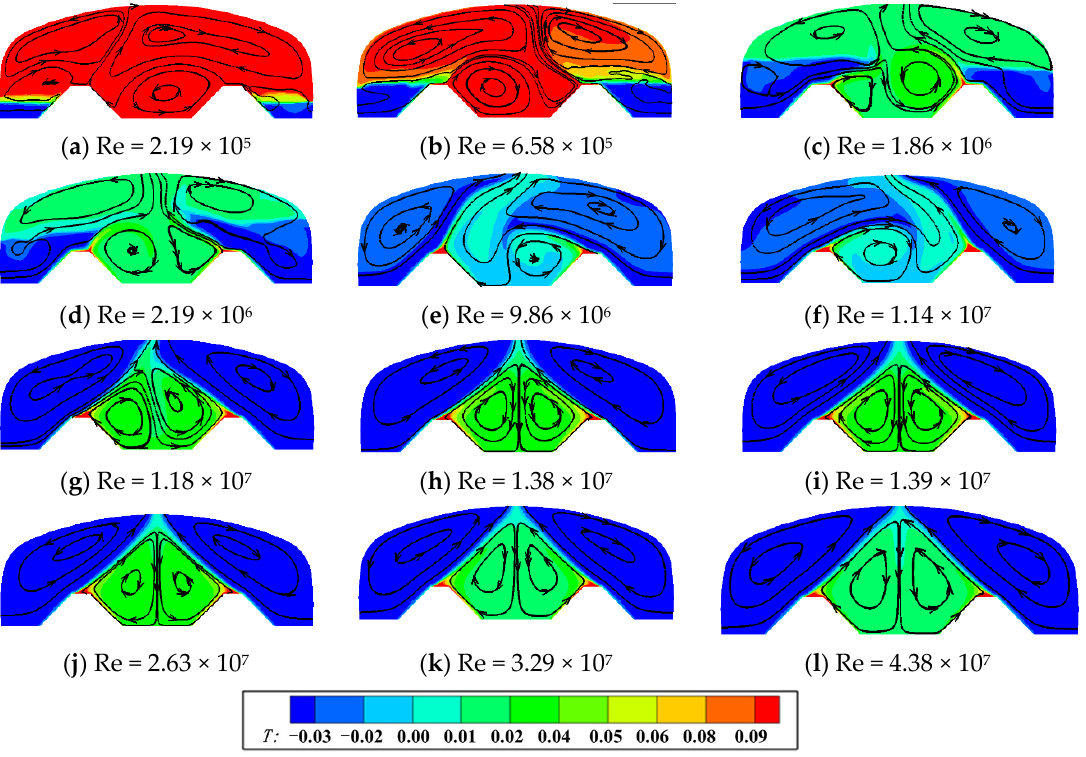
Figure 6. Fully developed stage of isotherms and streamlines in the arc-shaped cavities for different Re.